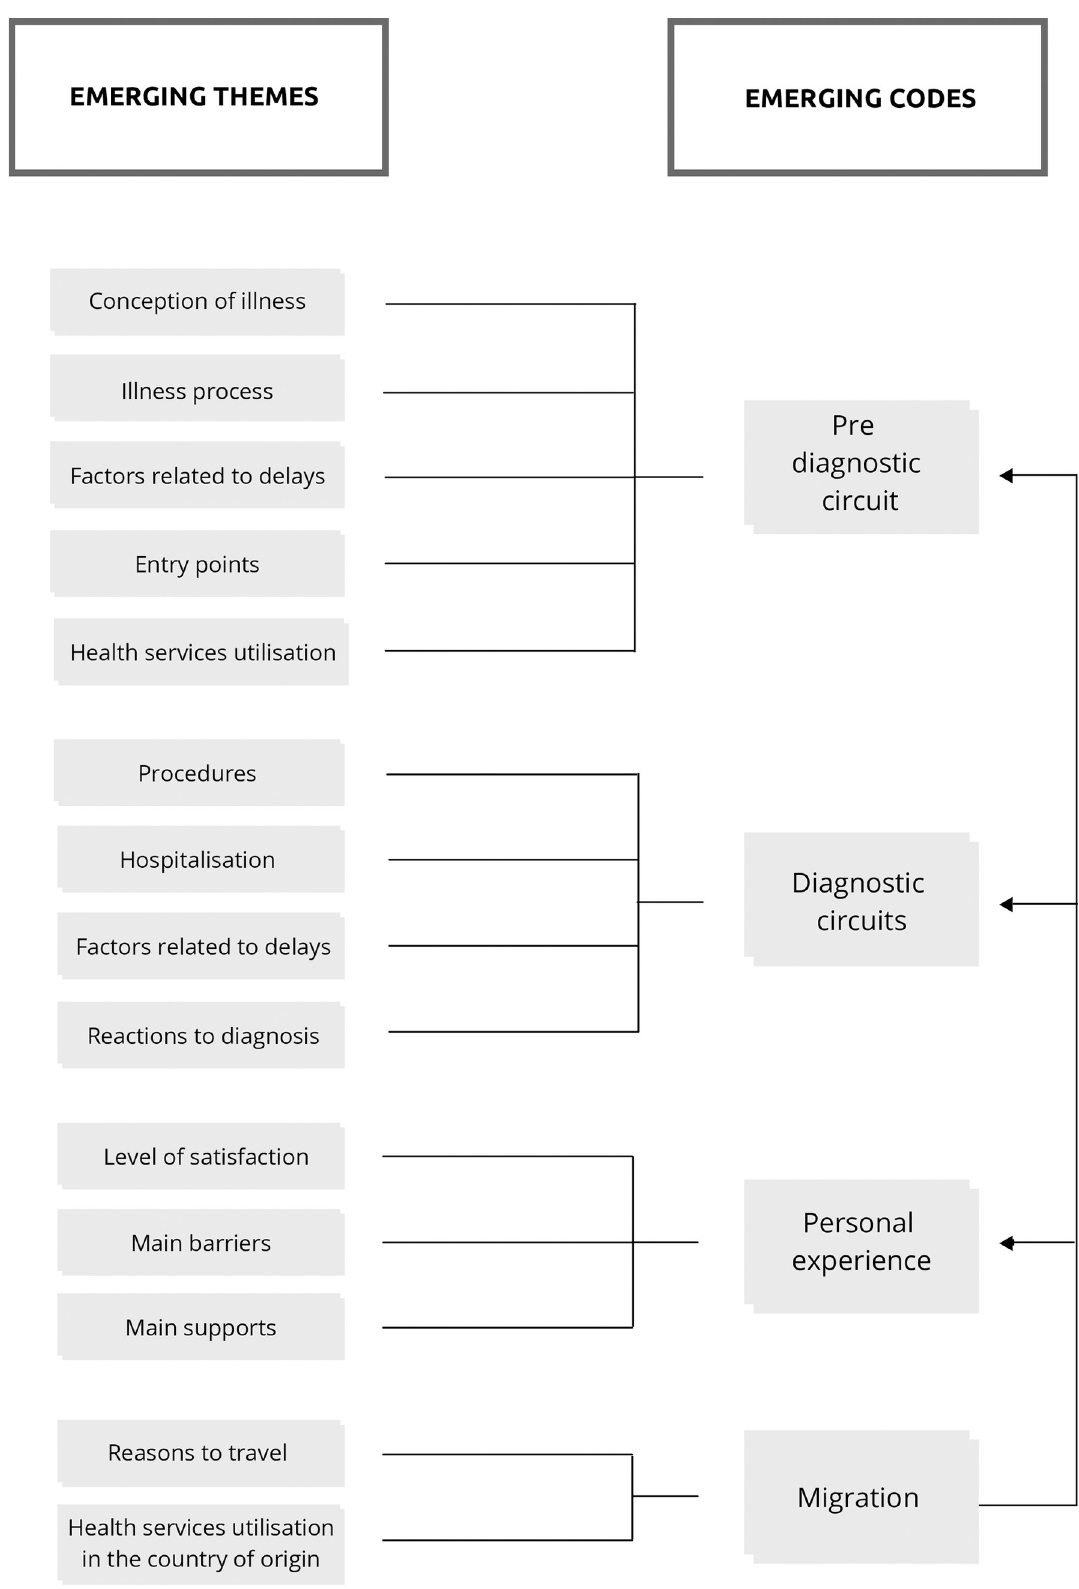
Fig 1. Main codes and themes emerging from the data deductively. https://doi.org/10.1371/journal.pone.0261688.g001 PLOS ONE | https://doi.org/10.1371/journal.pone.0261688 December28,